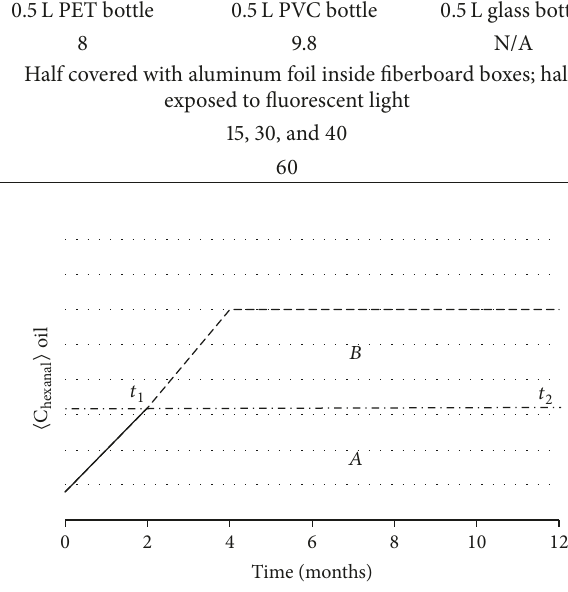
Figure 2: The graphical representation of the definition of 𝑃 safe . The threshold of the hexanal concentration is represented by the long dash dot line { adopted from Coutelieris and Kanavouras (2006) [34] }